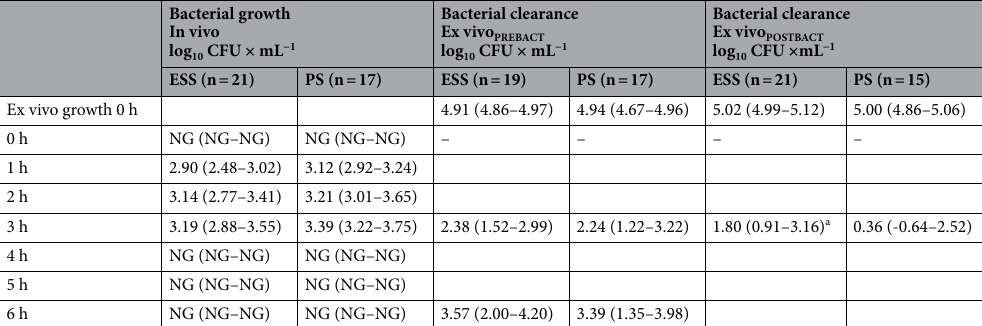
Bacterial growth In